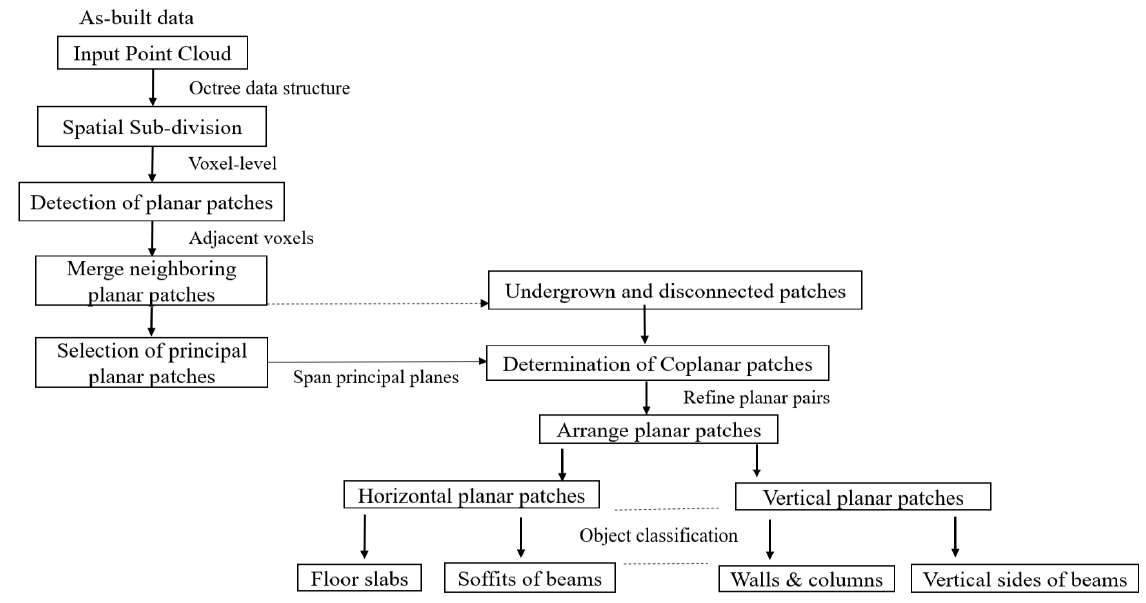
Figure 2. Overview of the developed approach.